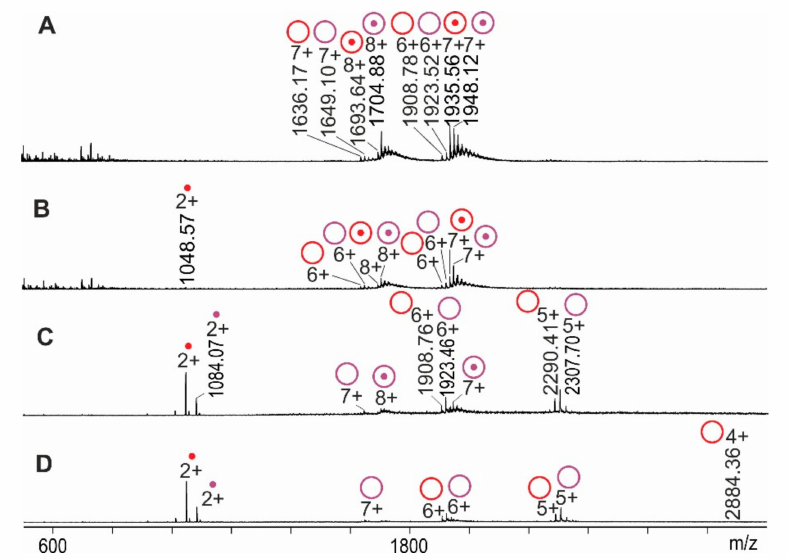
Figure 1. Nano-ESI mass spectra from RNAse S dissociation reactions. Collision cell voltage differ- ences ( ∆ CV ): ( A ): 4 V. ( B ): 10 V. ( C ): 30 V. ( D ): 50 V. Charge states and m / z values for selected ion signals are given. RNAse S ions (reddish circles with dots), S-protein ions (reddish circles without dots), and released S-peptide ions (reddish dots) each represent the two major molecular species (red: low molecular weight species; purple: high molecular weight species). Solvent: 2% acetic